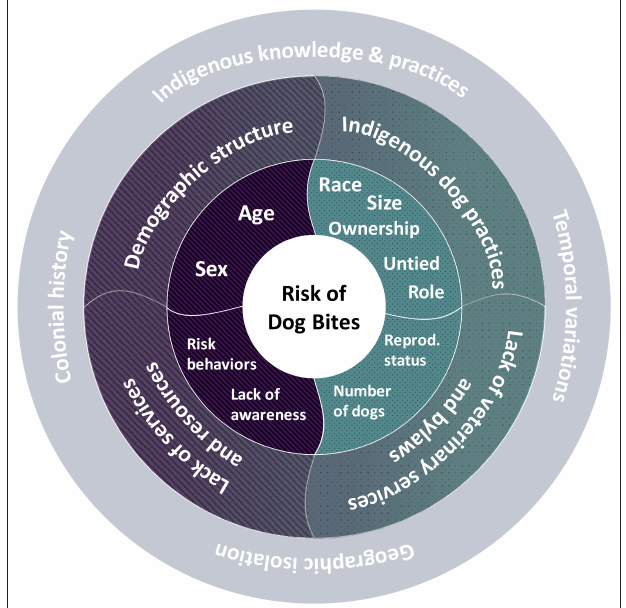
FIGURE 2 | Factors capable of influencing the risk of dog bites in northern Indigenous communities, ranked from individual/familial factors (such as age, sex, dogs’ ownership, and behavior toward dogs), to community factors (such as legislation and veterinary service), and contextual factors (such as seasonality and remoteness). (Hatched purple area), Human related factors; (Dotted turquoise area), Dog related factors; (Gray area), Contextual